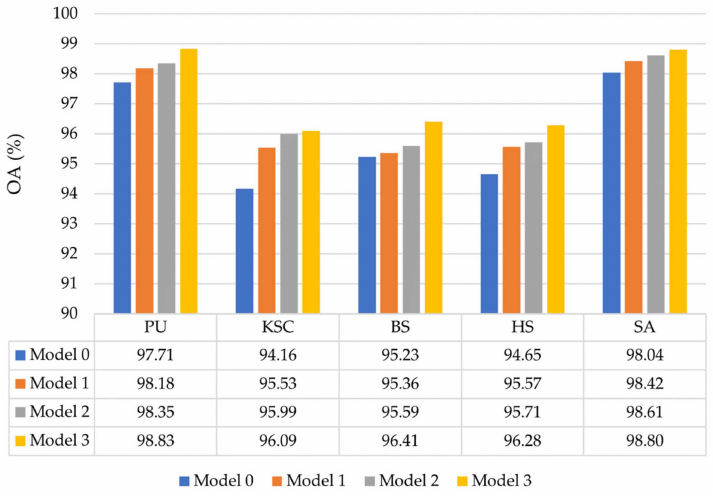
Figure 16. OA (%) of OSDN with different attention models on five